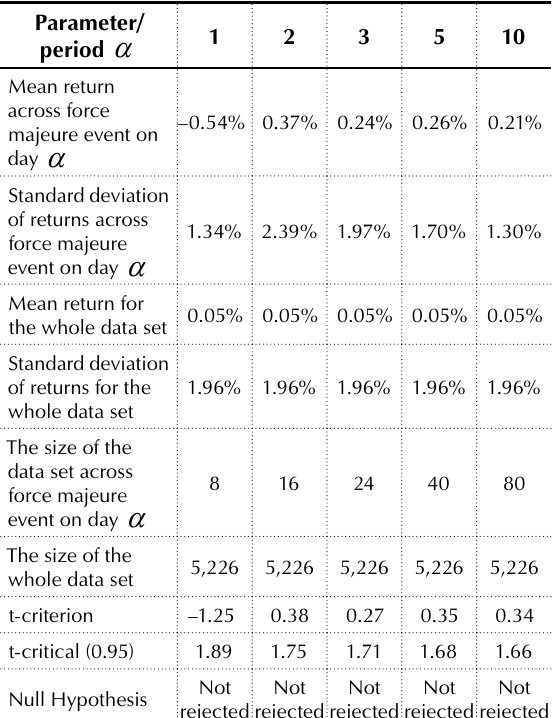
Table 3. T -test for the PFST returns over the